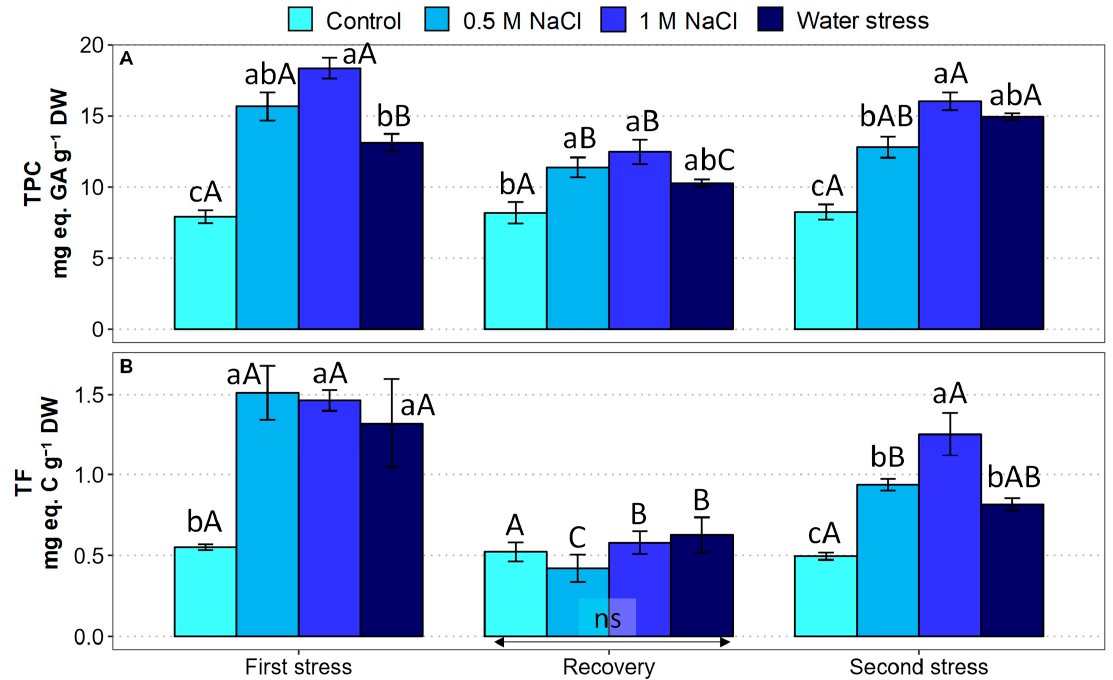
Figure 7. Effect of 30 days of stress treatment (First stress), followed by 15 days of watering with non ‐ saline water (Recovery) and by additional 15 days of stress (Second stress) on leaf concentration of antioxidant compounds in Limonium angustebracteatum plants. ( A ) Total phenolic compounds (TPC) and ( B ) total flavonoids (TF). Different lowercase letters over the bars indicate significant differences between treatments (Control, 0.5 M NaCl, 1 M NaCl, and Water stress) for each sampling, at p ≤ 0.05; ns: non ‐ significant. Different uppercase letters indicate significant differences between the three sampling times (First stress, Recovery, and Second stress) for each treatment, at p ≤ 0.05; ns: non ‐ significant. Vertical bars indicate standard error (n = 4).